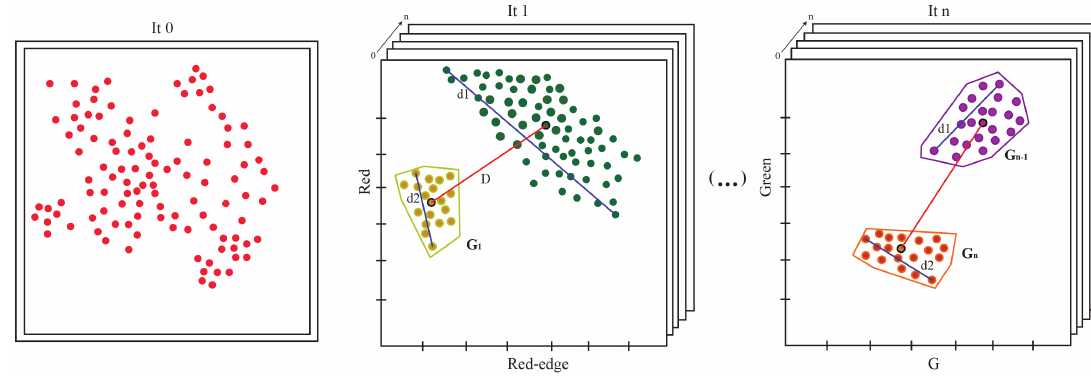
Figure 6. The main steps of the clustering